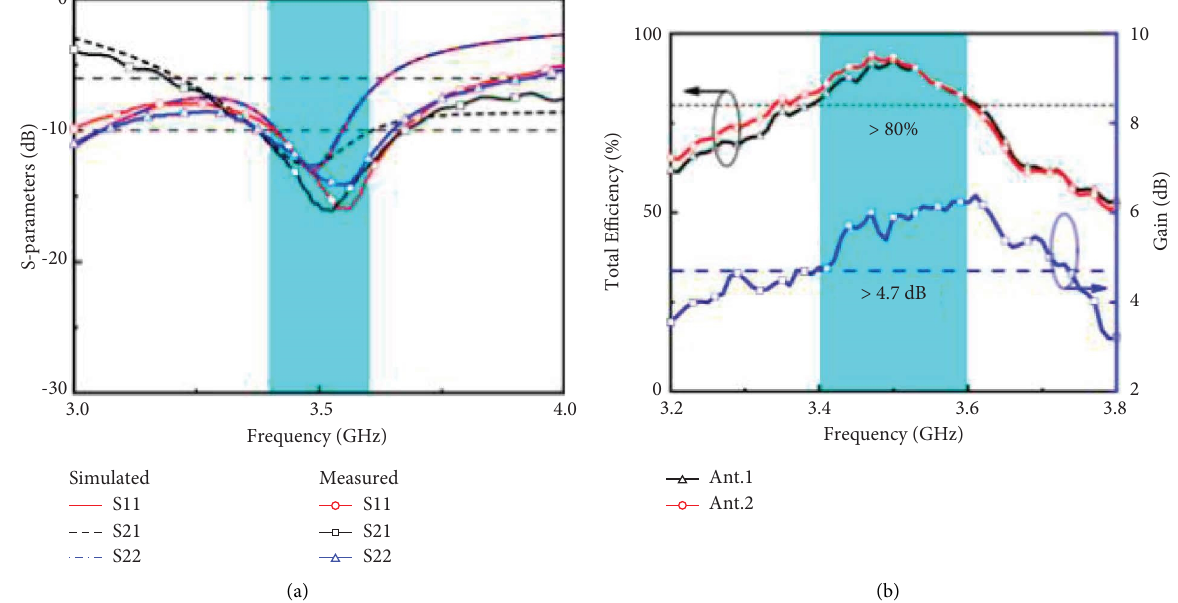
Figure 6: (a) Simulated and measured S -parameters. (b) Measured the total efciency and gain of the dual-port microstrip antenna pair.